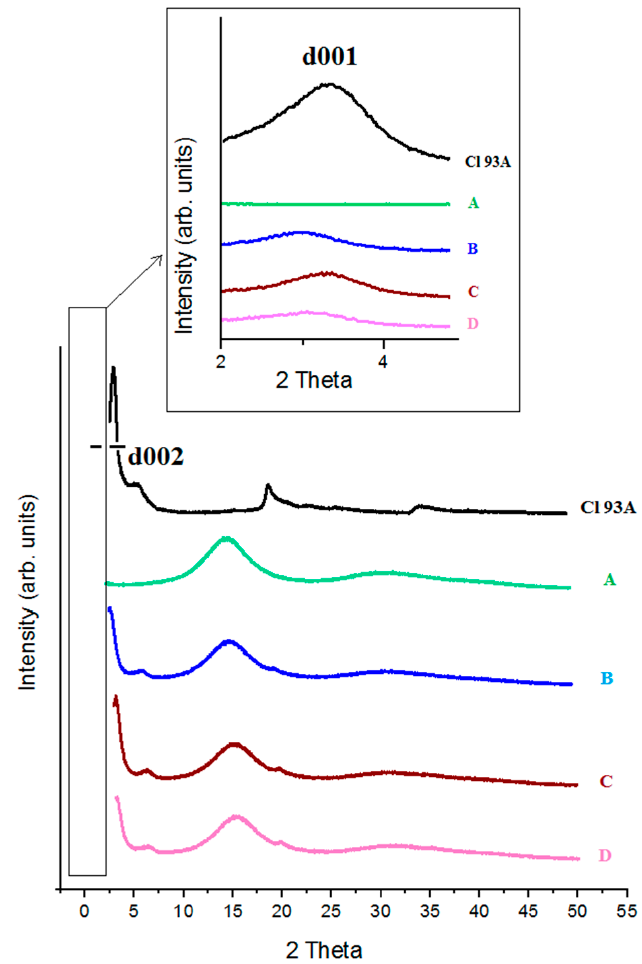
Figure 4. X-ray diffractograms registered for Cl 93A, PMAA ( A ), PMAA-Cl 93A ( B ), PMAA-Cl 93A-C8 ( C ), PMAA-Cl 93A-C18 ( D ); inset-Low angle XRD.